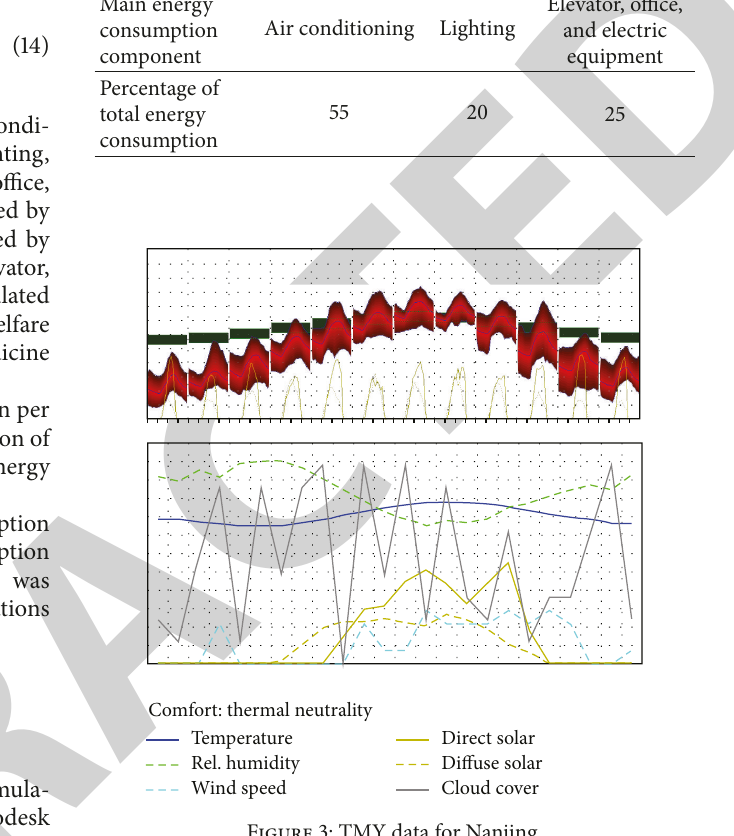
Figure 3: TMY data for